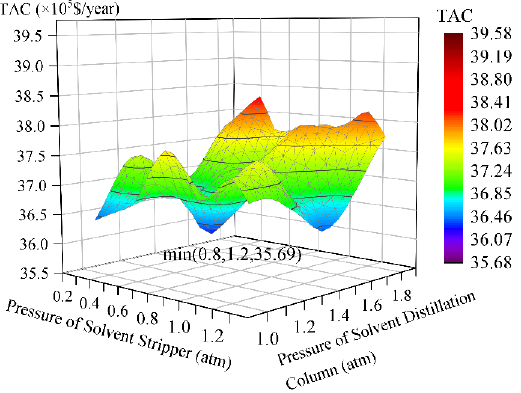
Figure 5. Effect of column pressure of solvent stripper and solvent distillation column on the total annual cost of the heat integration